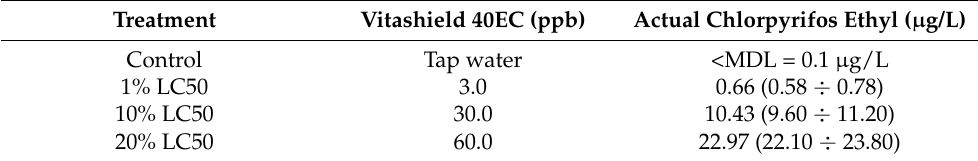
Table 3. Actual concentrations of chlorpyrifos ethyl in the growth performance experiment. Treatment